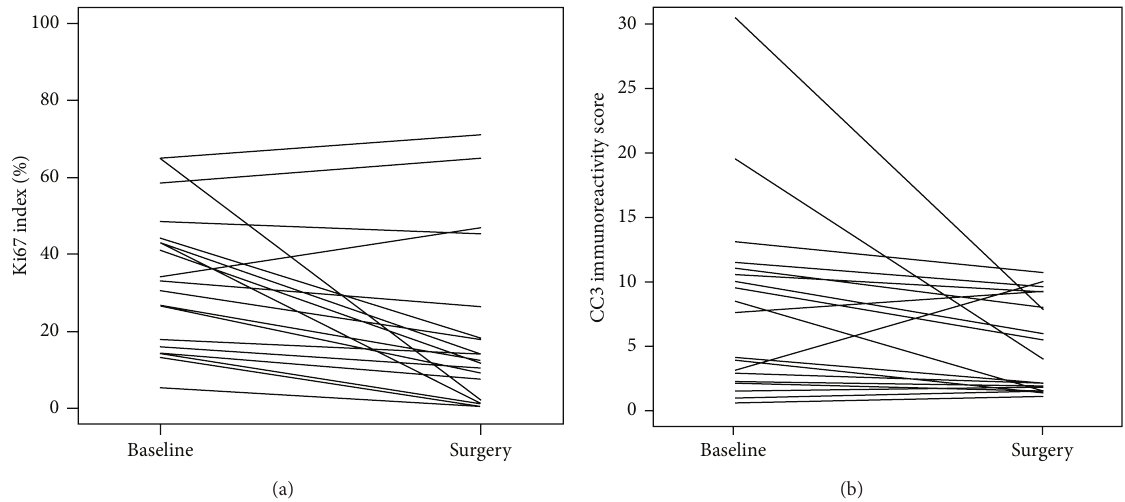
Figure 3: Ki67 labelling index (a) and cleaved caspase 3 (CC3) (b) at baseline and after anastrozole treatment at surgery.